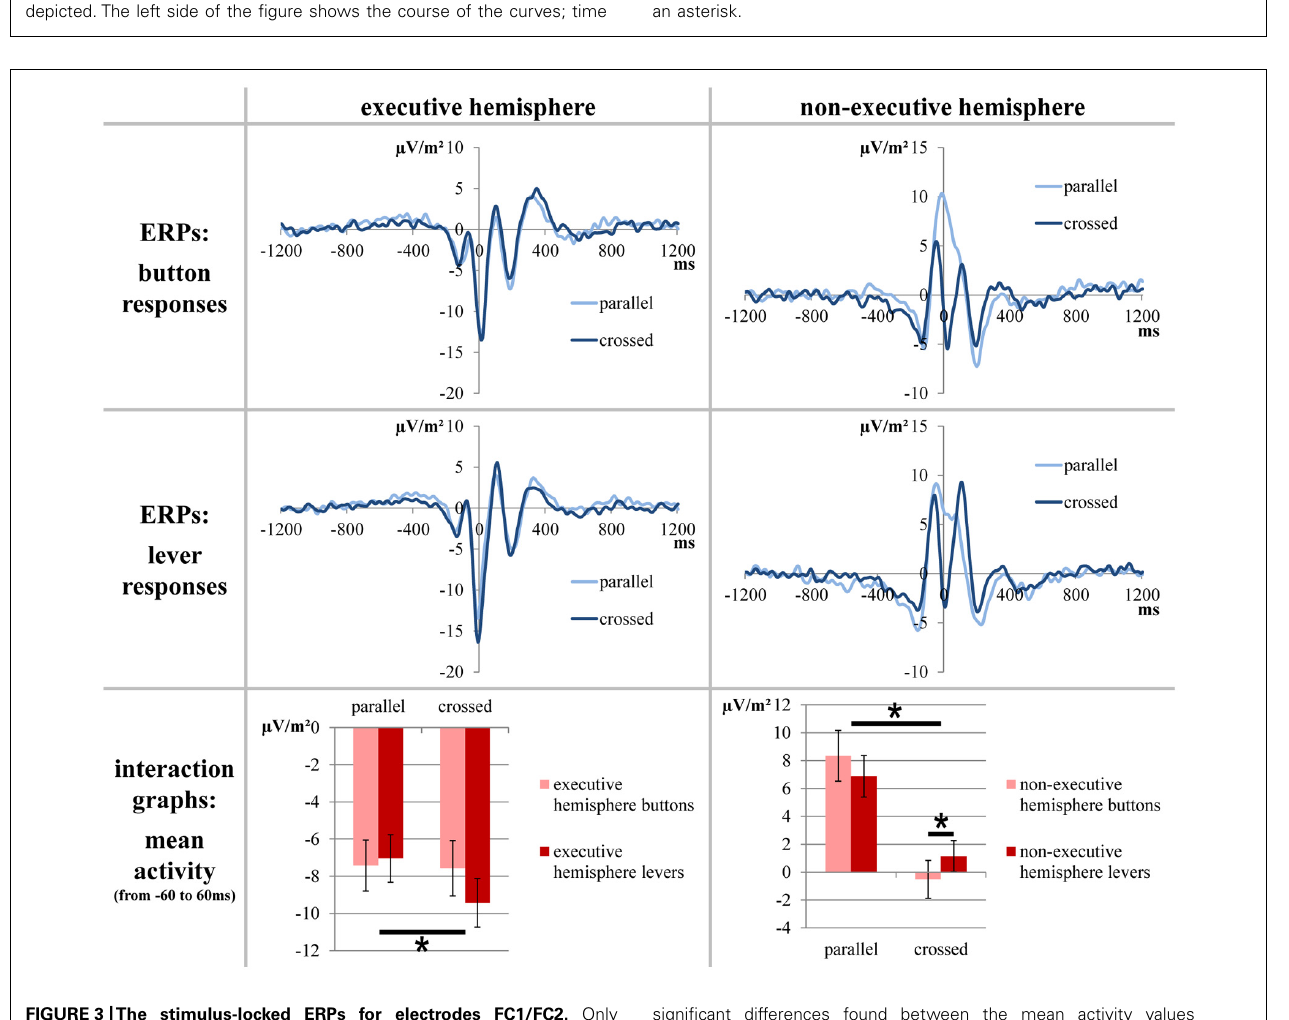
FIGURE 3 |The stimulus-locked ERPs for electrodes FC1/FC2. Only factors yielding significant results are depicted. The upper parts of the figure show the course of the curves; time point zero denotes the response. The lower part of the figure elucidates the